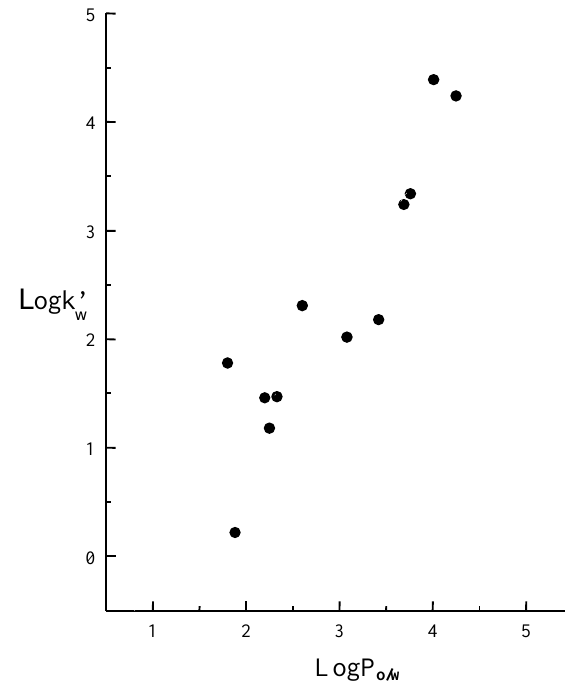
and log P for ODS w o/w